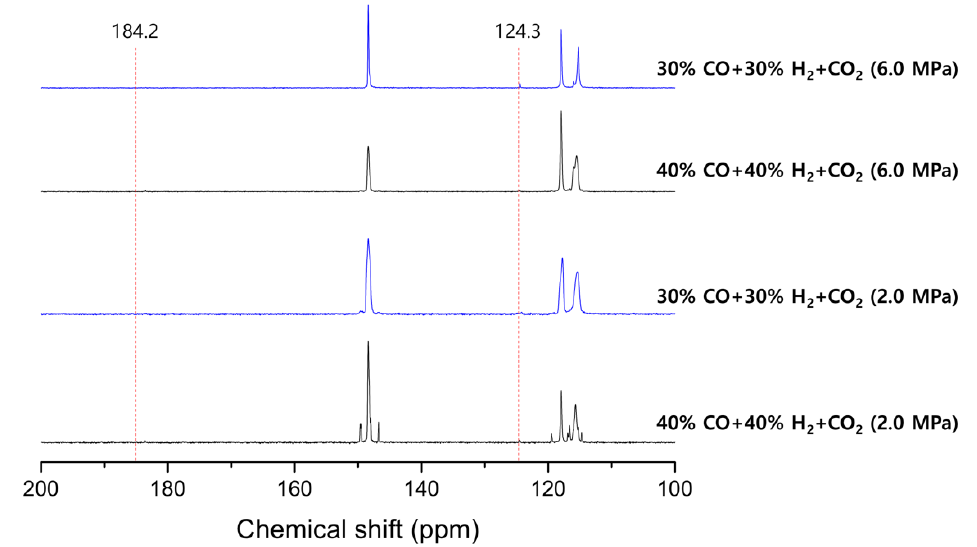
Figure 2. Solid-state 13 C NMR spectra for hydroquinone (HQ) samples after reaction with ternary (CO 2 + CO + H 2 ) gas mixtures at 2.0 and 6.0 MPa. Blue plots represent HQ samples after reaction with the ternary (30% CO + 30% H 2 + 40% CO 2 ) gas, while black ones represent HQ samples after reaction with the ternary (40% CO + 40% H 2 + 20% CO 2 ) gas. Dashed lines at 184.2 and 124.3 ppm represent the chemical shifts from CO and CO 2 molecules captured in the clathrate cages, respectively.